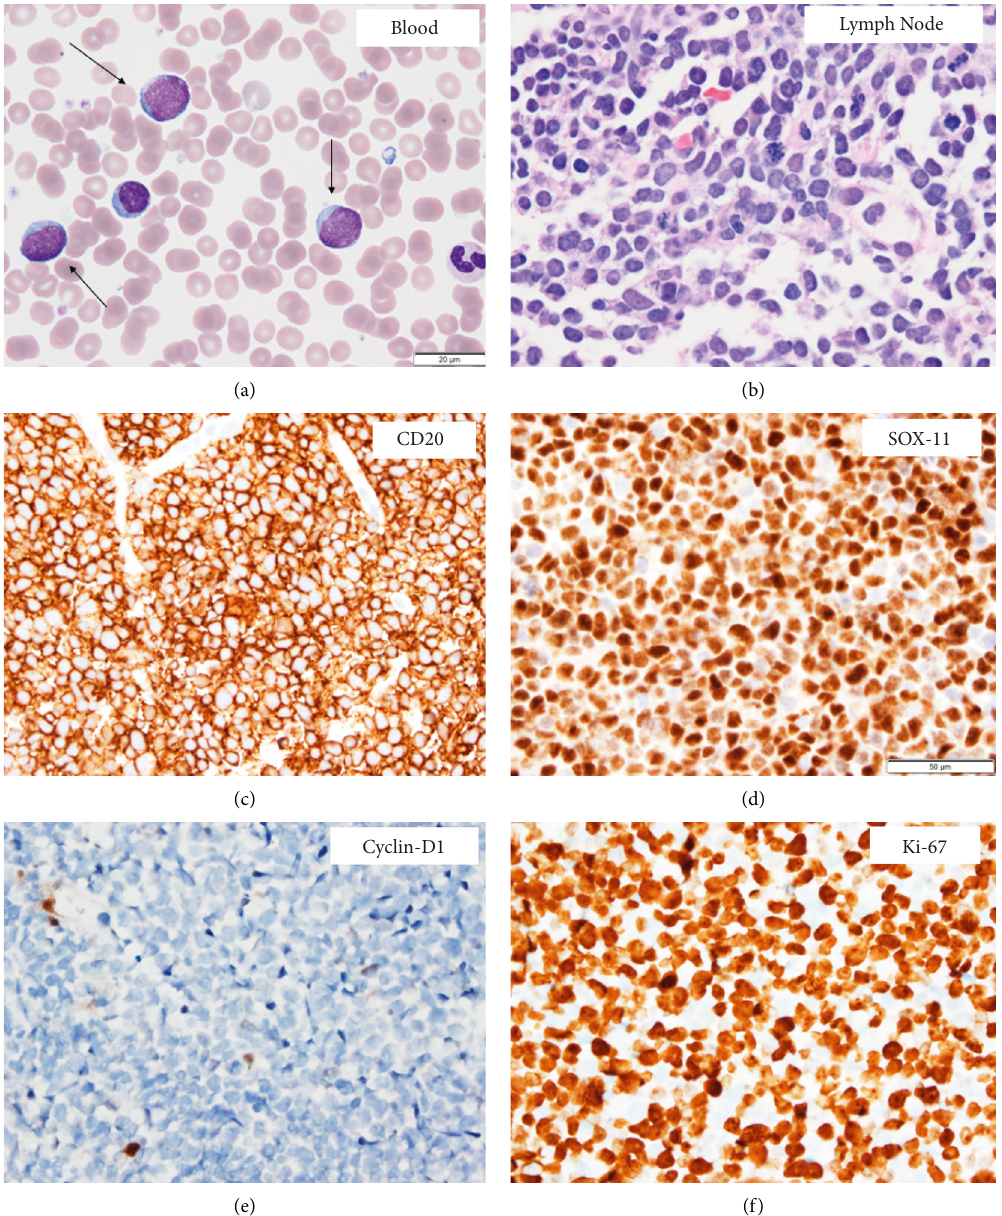
Figure 1: (a) Wright–Giemsa stain of peripheral blood smear shows circulating large atypical lymphoid cells, highlighted with arrows (1000 × ). (b) The hematoxylin and eosin section shows diffuse proliferation of large pleomorphic lymphoid cells in the cervical lymph node (600 × ). (c–f) Immunohistochemical stains (all 600 × ) demonstrate that the cervical lymph node neoplastic cells are positive for CD20 and SOX-11, while negative for cyclin-D1. Ki-67 highlights a very high proliferative index of ∼